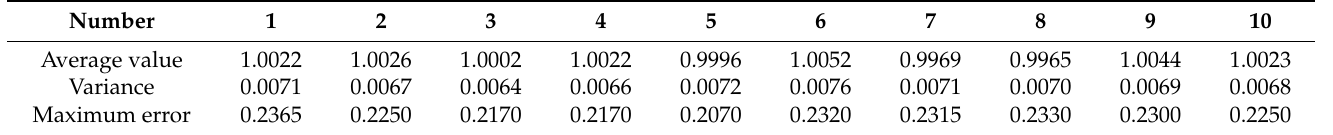
Figure 5. The probability density distribution histogram of the neuron stretch device with a one- µ m step. Table 2. The statistical analysis of neuron stretch device with a one- µ m step.